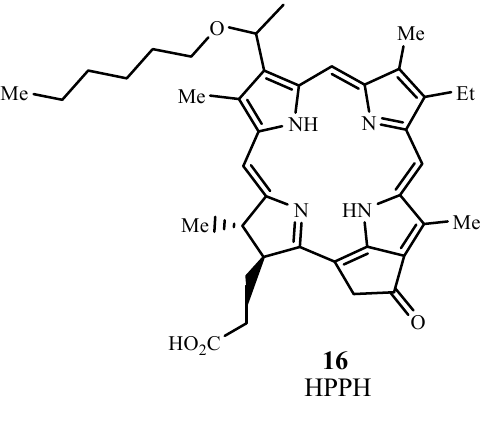
Figure 12. Molecular structure of 2-(1-hexyloxyethyl)-2-devinyl pyropheophorbide (HPPH).